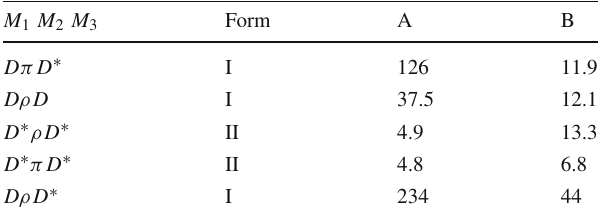
Table 1 Parameters for the form factors in the M 1 M 2 M 3 vertex. The meson M 1 is